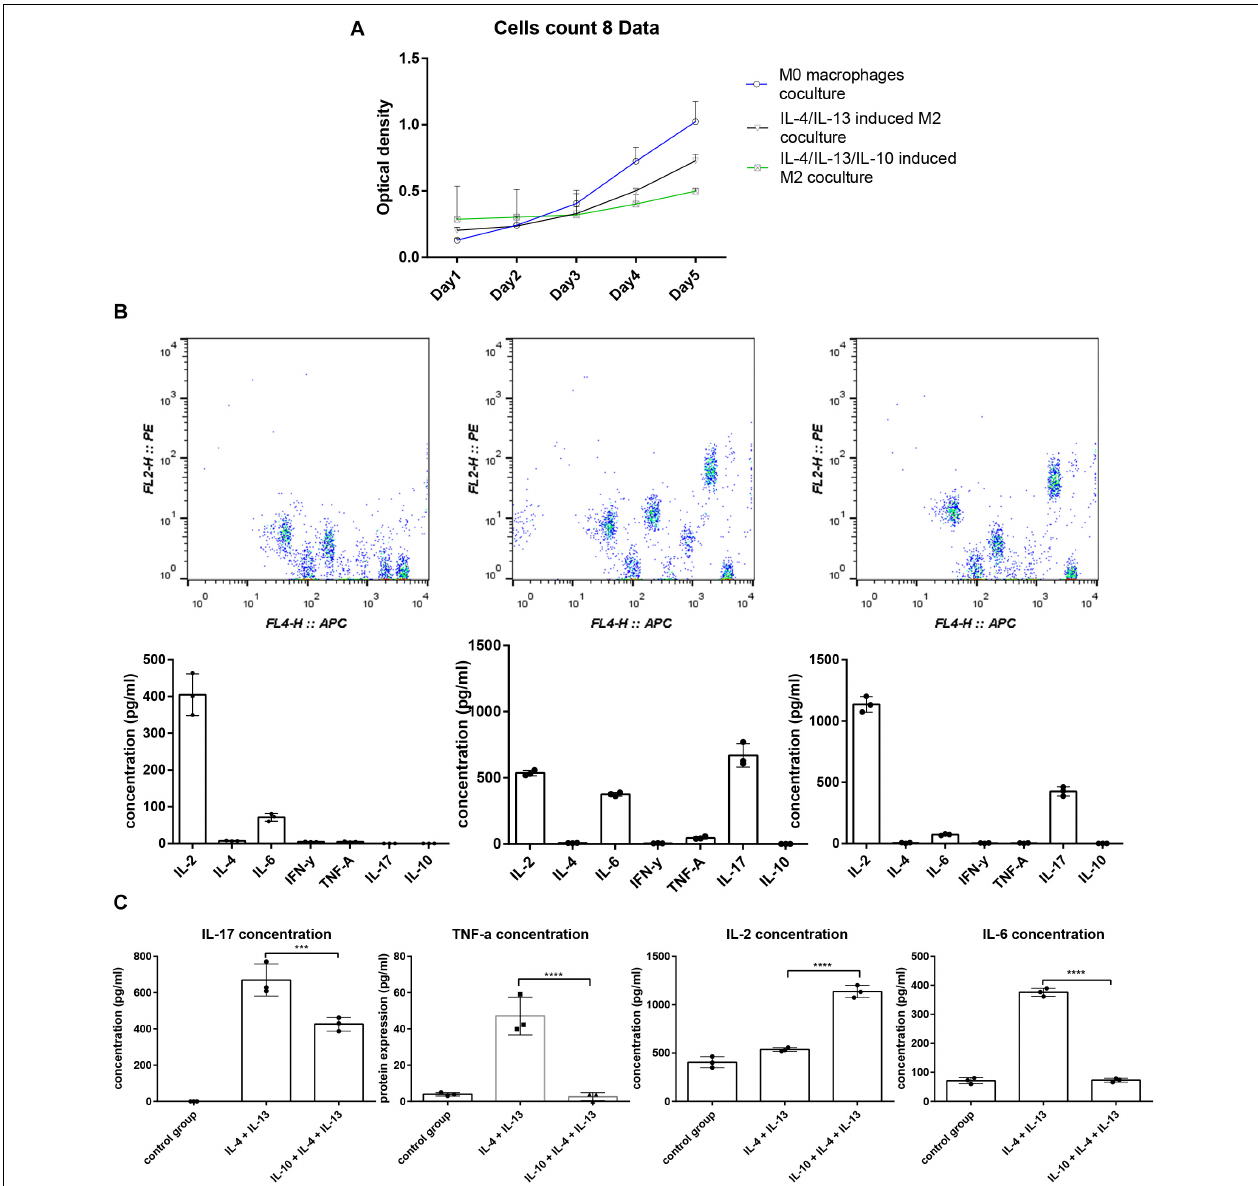
FIGURE 2 | The splenocyte proliferation analysis and cytokine profile difference cocultured with macrophages. (A) Five days of splenocyte proliferation in the mixed culture using CCK-8 kit. The relative cell count is represented by optical density (OD) value. (B) CBA analysis of cytokine profiles in the supernatant of mixed